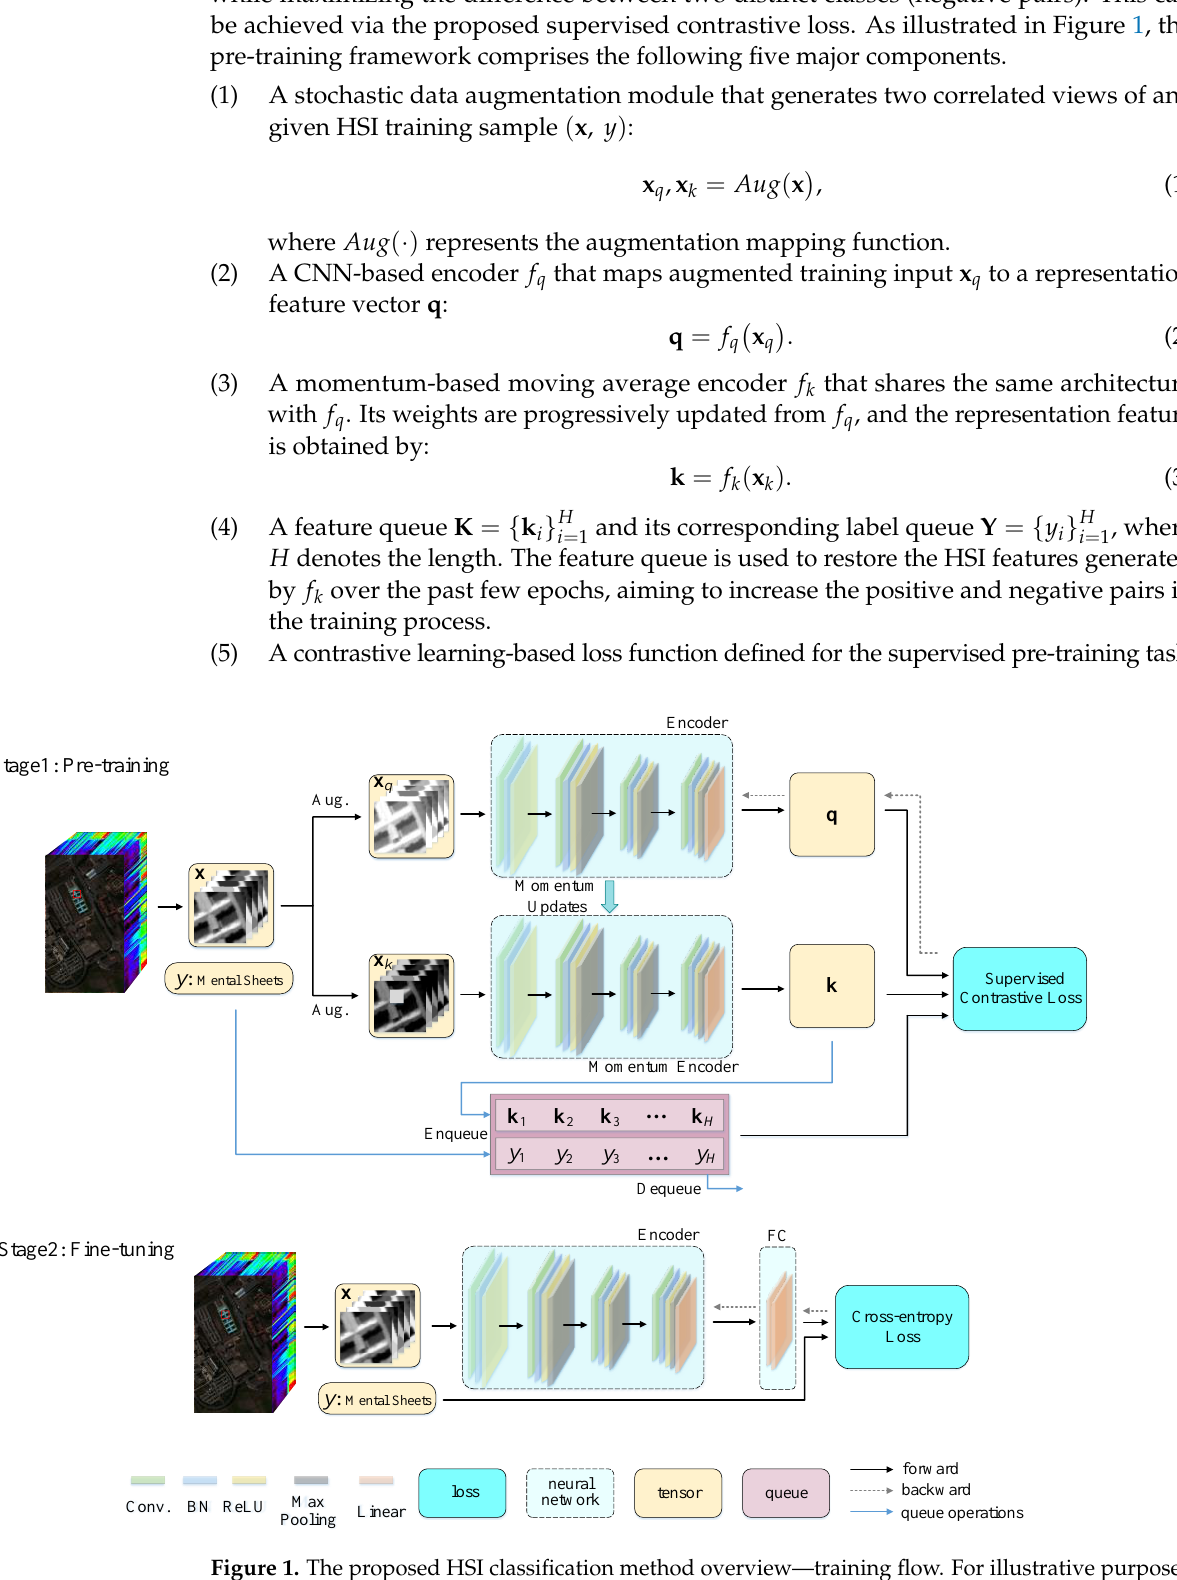
Figure 1. The proposed HSI classification method overview—training flow. For illustrative purposes, a single image flow instead of a batch is shown here. Stage 1: pre-training based on supervised contrastive learning. Stage 2: fine-tuning for the final classification task.